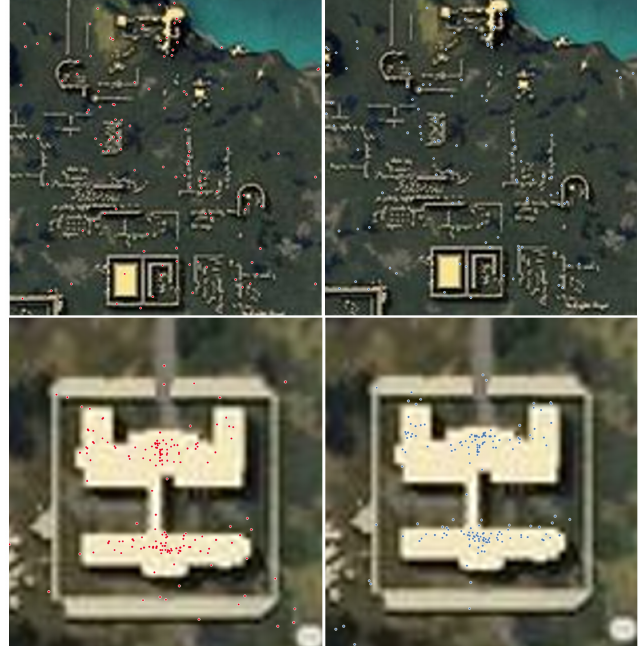
Figure 8. (On the upper right and upper left figure, the figure illustrates the victims (red) and killers (blue) within the ‘Ruin’ area. On the lower right and upper left figure, the figure illustrates the victims (red) and killers (blue) within the ‘Hospital’